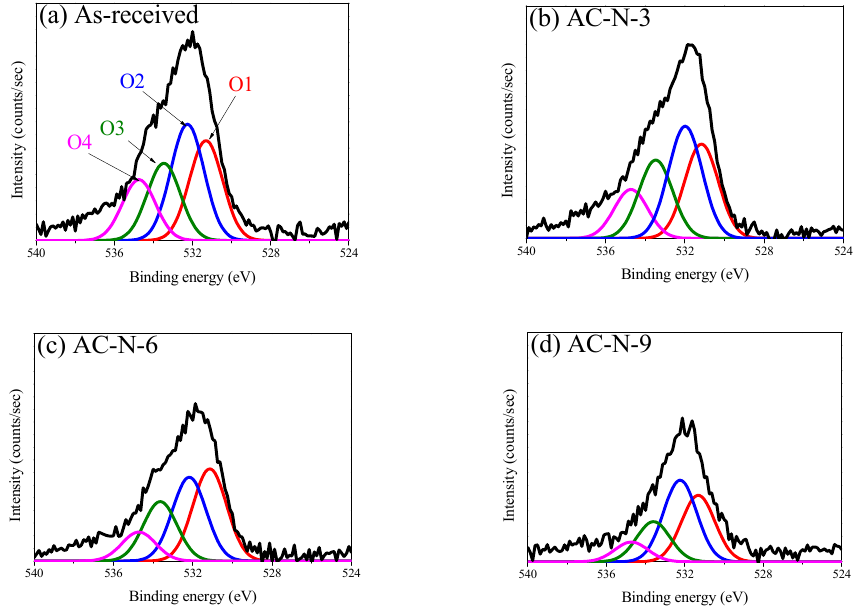
Figure 3. High ‐ resolution O 1S spectra of AC ‐ N; ( a ) As ‐ received, ( b ) AC ‐ N ‐ 3, ( c ) AC ‐ N ‐ 6, ( d ) AC ‐ N ‐ 9.